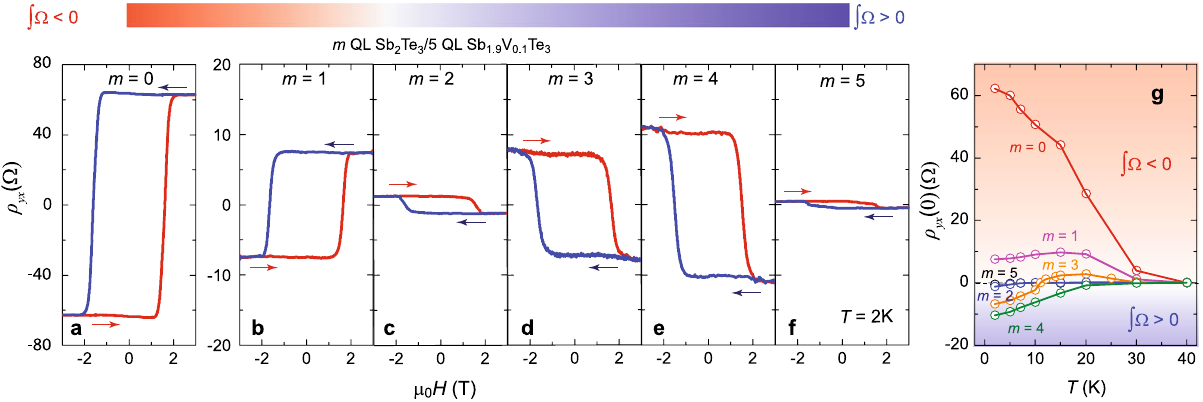
Fig. 2 Interface-induced sign reversal of the AH effect in TI/magnetic TI heterostructures. a – e Magnetic fi eld ( μ 0 H ) dependence of the Hall resistance ρ yx in m QL Sb m = 0 ( a ); m = 1 ( b ); m = 2 ( c ); m = 3 ( d ); m = 4 ( e ); m = 5 ( f ). The arrows indicate 2 Te 3 /5 QL Sb 1.9 V 0.1 Te 3 bilayer heterostructures. the magnetic fi eld sweep directions. All measurements were taken at T = 2 K. The linear contribution from the ordinary Hall effect was subtracted. g Temperature dependence of the Hall resistance at zero magnetic fi eld ρ yx (0) in m QL Sb 2 Te 3 /5 QL Sb 1.9 V 0.1 Te 3 bilayer